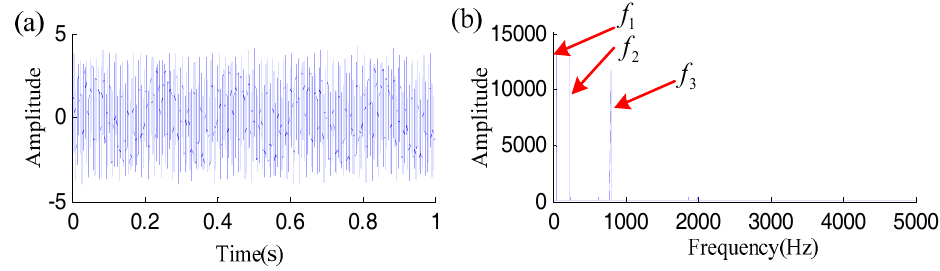
Figure 6. The time and frequency waveform of the last layer approximation signal. ( a ) The waveform of the last layer approximation signal in the time-domain. ( b ) The waveform of the last layer approximation signal in the frequency-domain.